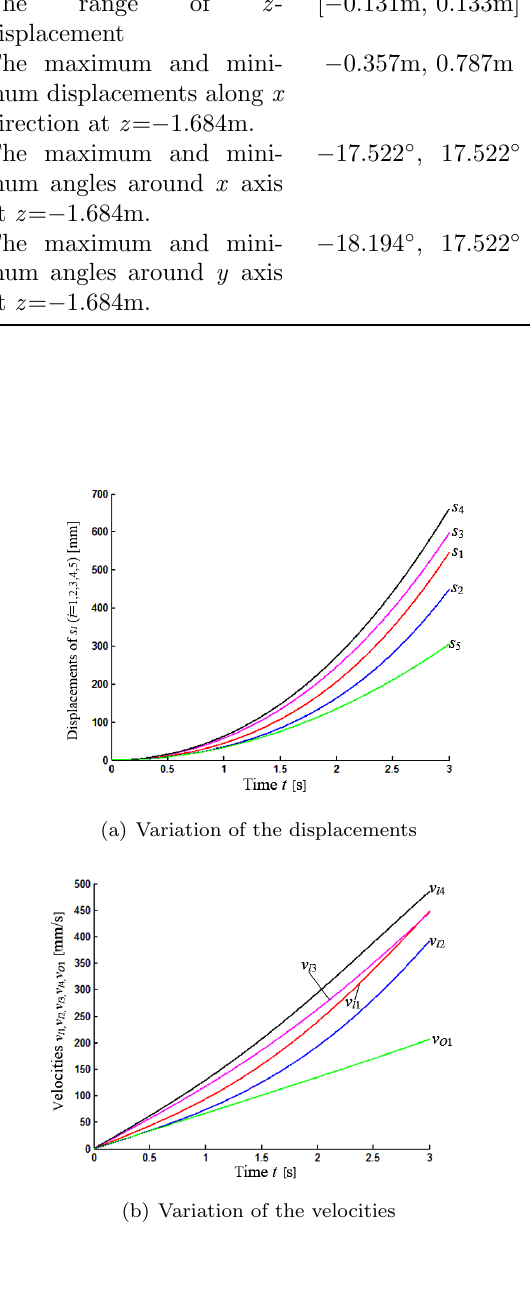
Figure 9: The slender structural part